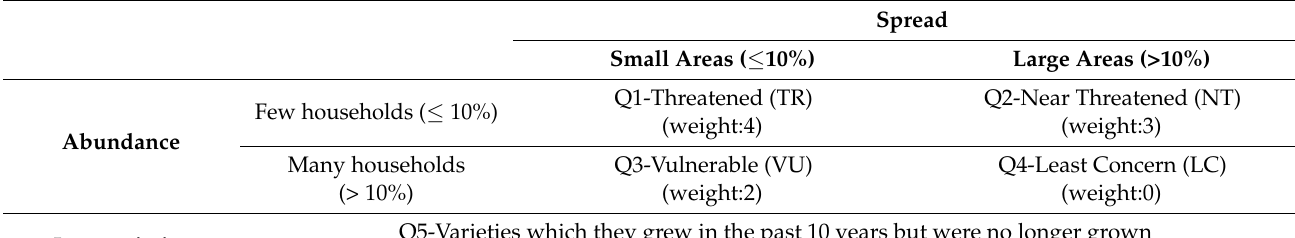
Table 2. Four-cell analysis used for collecting varietal information across sites and quadrants (Q). Weight values are given in the parenthesis.